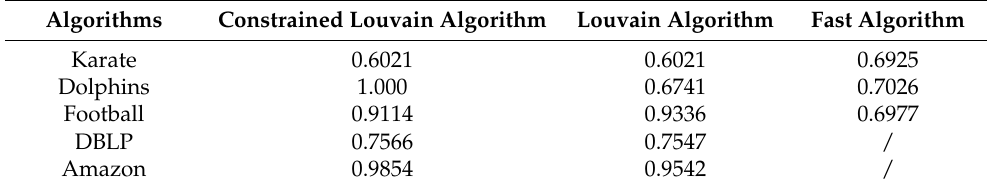
Figure 2. For the LFR networks, the relationship between the values of NMI and the values of each parameter. ( a ) µ is changed when γ = 2.5, β = 1.5 and (cid:104) k (cid:105) = 20. ( b ) γ is changed when µ = 0.3, β = 1.5 and (cid:104) k (cid:105) = 20. ( c ) β is changed when µ = 0.3, γ = 2.5 and (cid:104) k (cid:105) = 20. ( d ) (cid:104) k (cid:105) is changed when µ = 0.3, γ = 2.5 and β = 1.5. The results are averaged for 100 networks with N = 1000. Table 3. The NMI values for the constrained Louvain algorithm with F2, Louvain algorithm with F2 and Newman fast algorithm on the ground truth networks. The / means the algorithm cannot be executed for the large